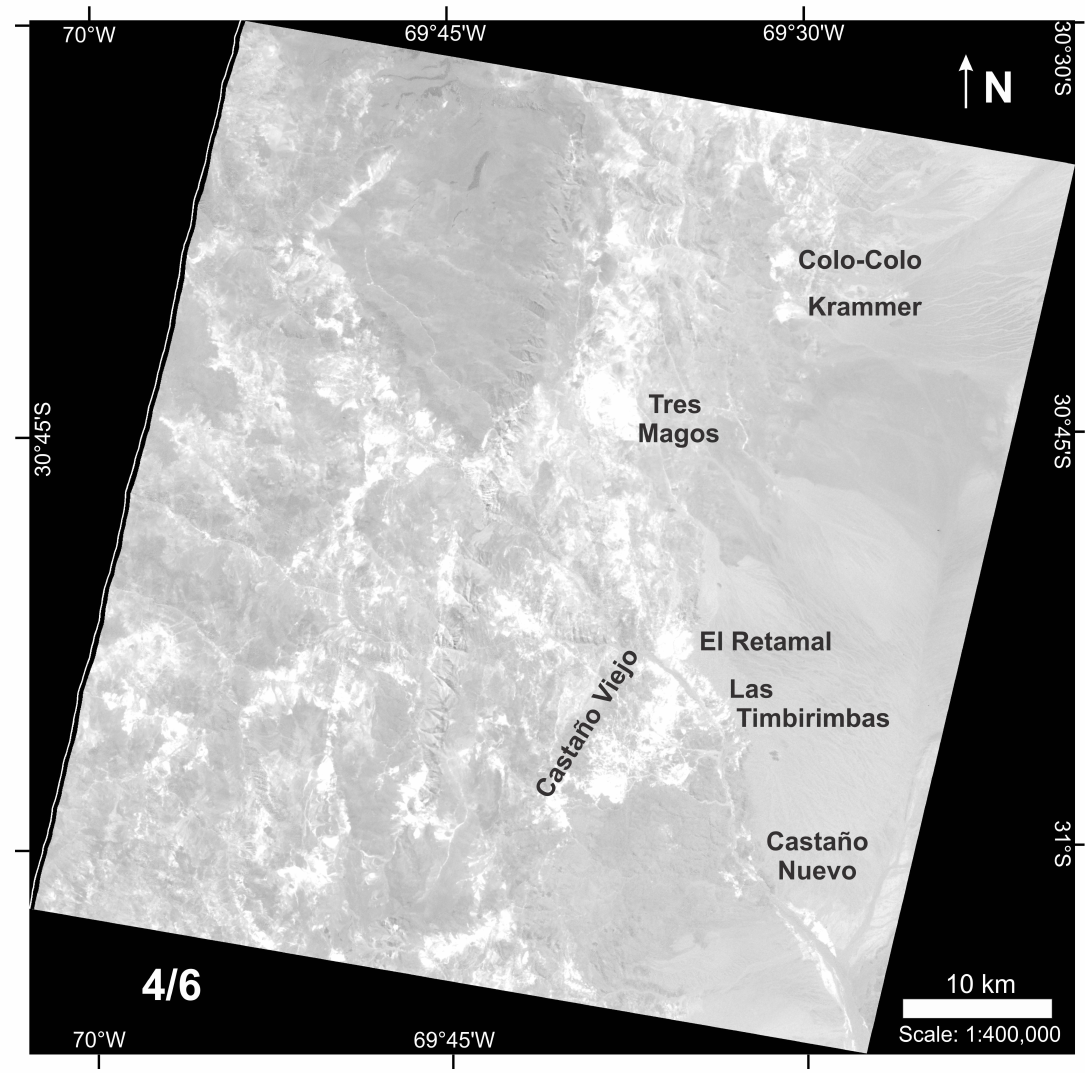
Figure A3. Grey-scale image with the ASTER band ratio 4/6. This band ratio is a good hydrothermal alteration discriminator; it highlights argillic and phyllic alteration in bright colors. It does not provide information regarding lithologic units or areas with silicic